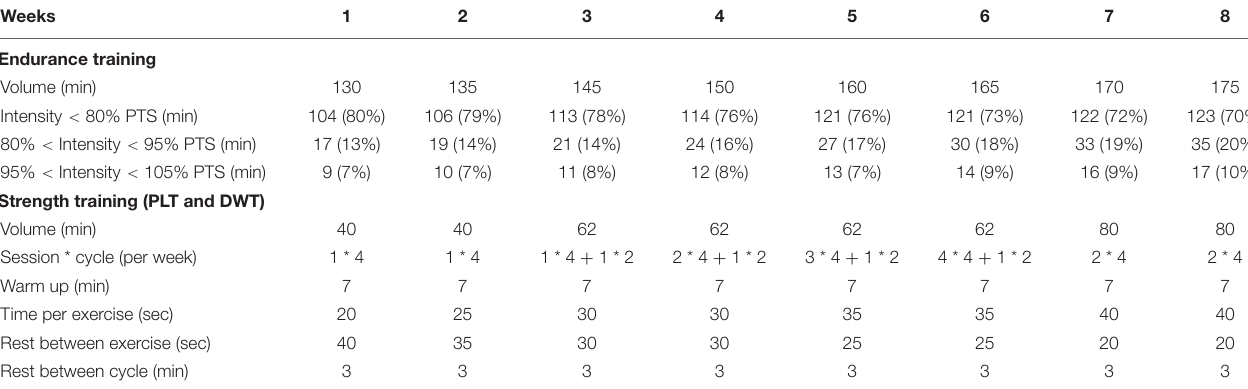
TABLE 2 | Characteristics of the 8 weeks training program.